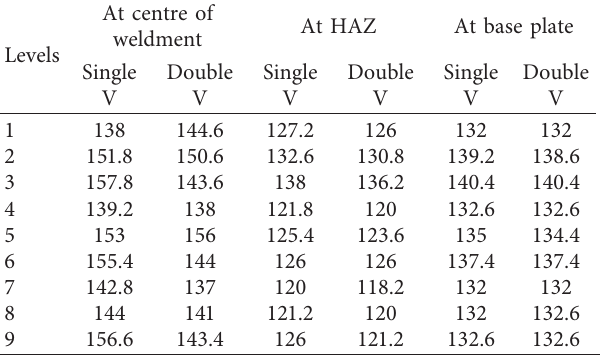
Table 11: Hardness